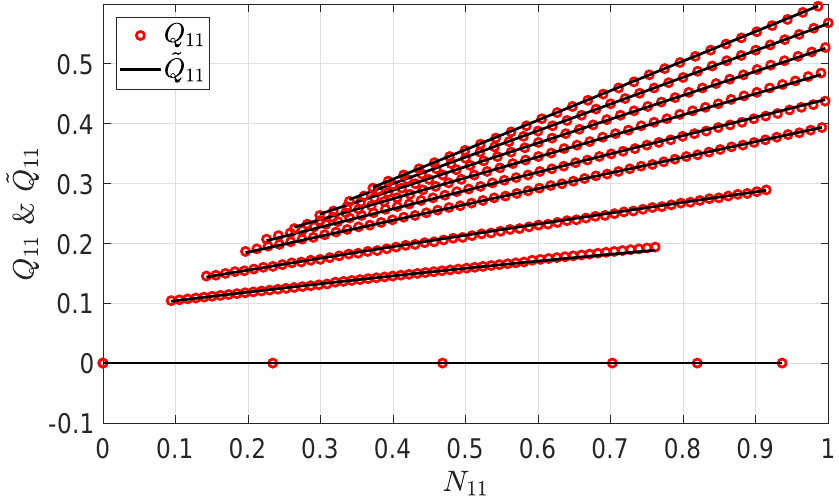
Figure 3. ˜ Q 11 vs. N 11 for different values of γ